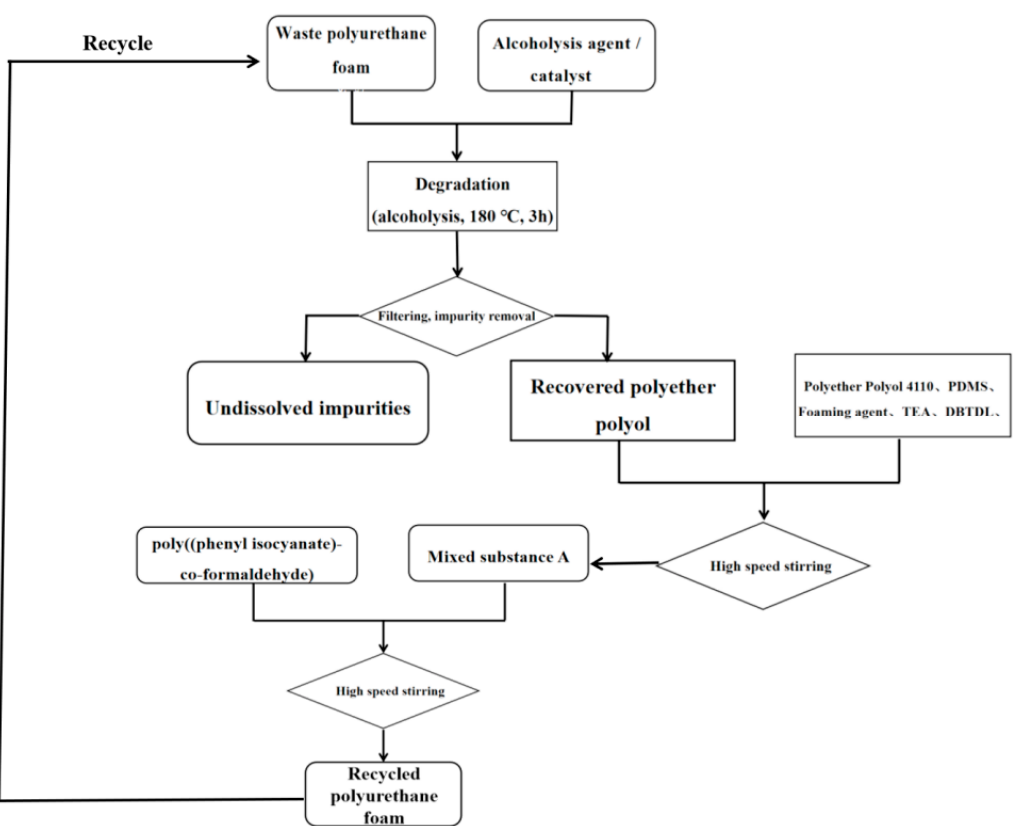
Figure 5. Outline of possible products obtained from the alcoholysis process.